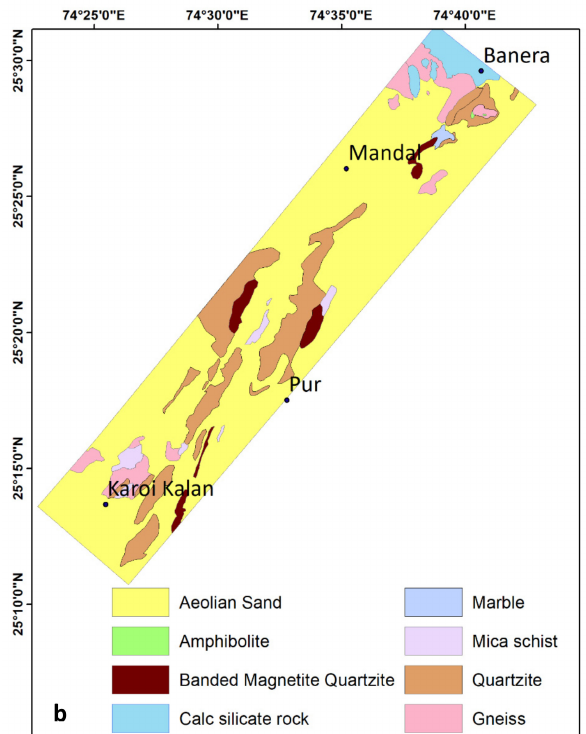
Figure 1. ( a ) AVIRIS-NG false-color composite (FCC)map of Pur-Banera area. In the figure, AVIRIS-NG image strips from two successive airborne acquisitions are shown. A few important locations within the study area are also shown. For FCC image, Red = 850 nm, Green = 650 nm and Blue = 560 nm bands were used; ( b ) Lithological map showing the disposition of major rock